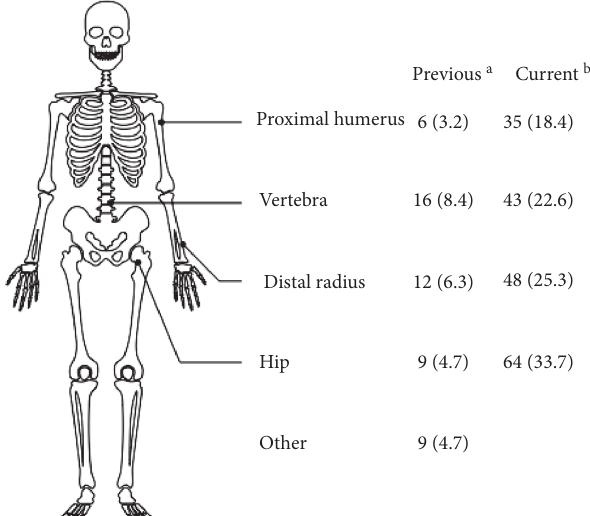
Figure 2: Previous and current fragility fracture sites. Data are expressed as numbers (percentage). a Before the program; b during the study period (year 1 of the